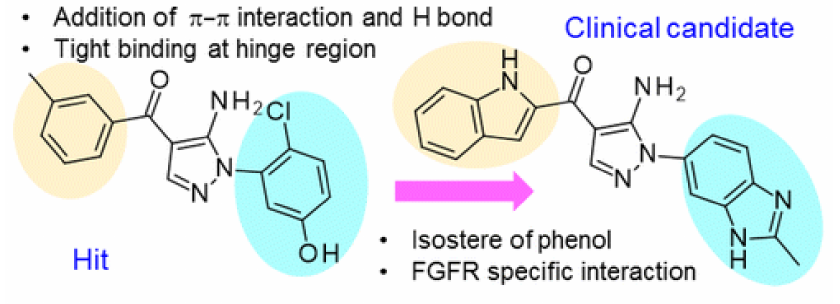
Figure 34. Hit-to-lead rational design of CH5183284